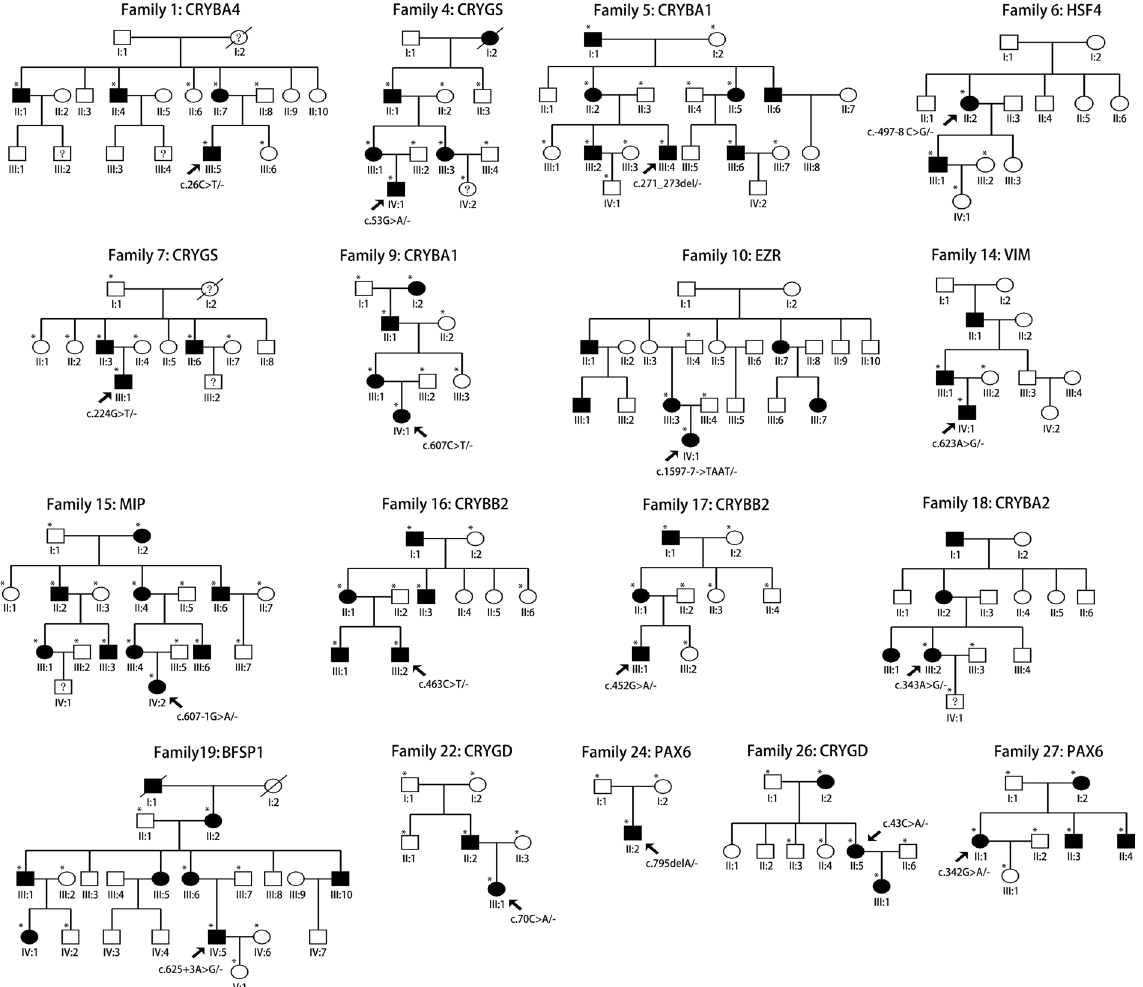
Figure 1. Pedigrees of the families with mutations. Squares indicate men and circles women; black and white symbols represent affected and unaffected individuals, respectively. The proband is marked with an arrow, and asterisks indicate those members enrolled in this